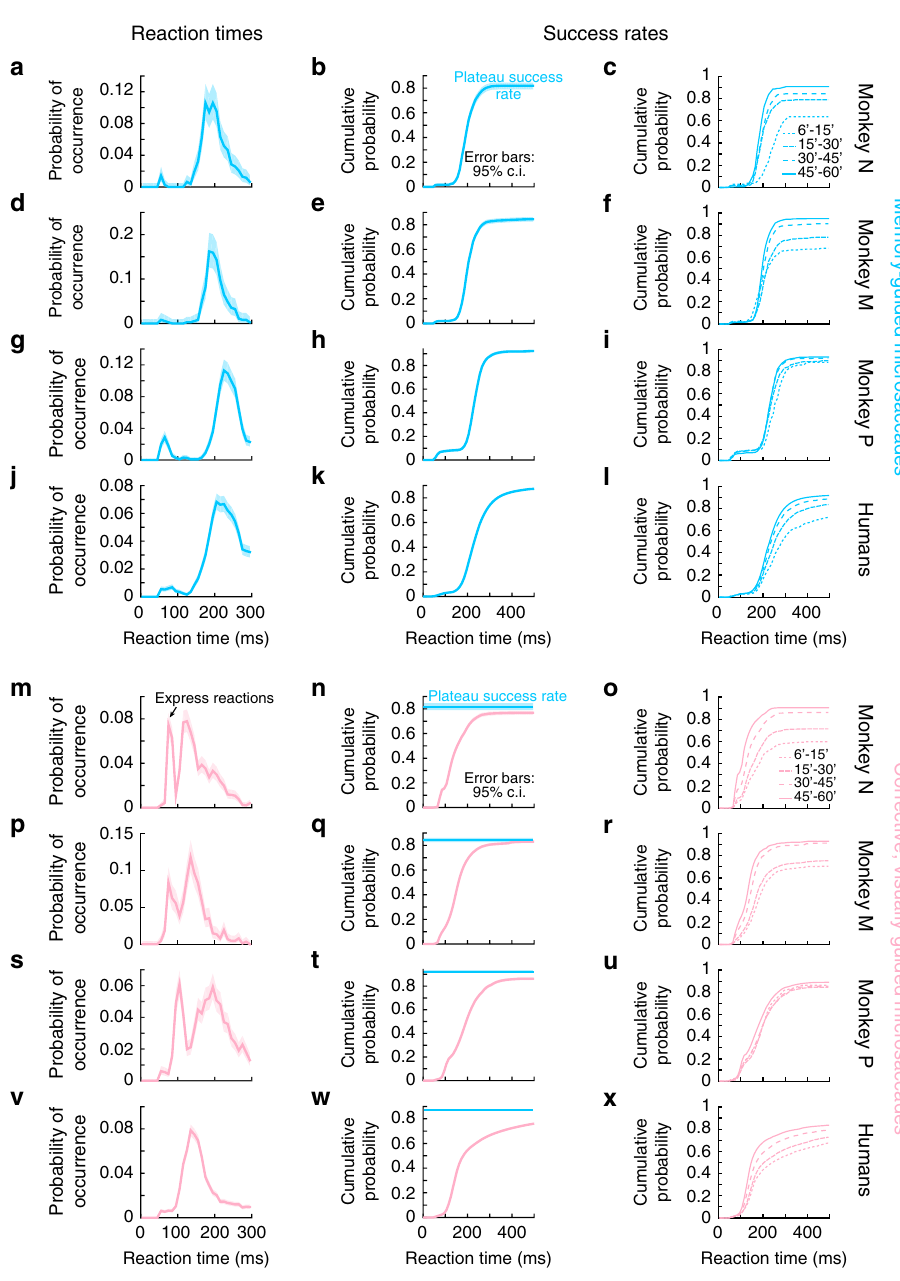
Fig. 2 Memory-guided microsaccades had reaction times and success rates consistent with being genuine responses to task instruction. a Reaction time distribution for memory-guided microsaccades in monkey N. The data shows all trials with target eccentricities <1 o (Methods). The monkey had a reaction time distribution typical of saccadic responses. Error bars denote 95% con fi dence intervals, and the histogram was normalized by the total number of trials. b Cumulative probability of the same data, demonstrating a plateau of >80% success rate; the monkey successfully generated a memory-guided microsaccade (that is, within a reasonable reaction time; Methods) on the great majority of trials. Error bars denote 95% con fi dence intervals. c Same data as in b but separated by target eccentricity (inset legend). Even the smallest target eccentricities were associated with a majority of successful reactions. d – f Similar observations from monkey M. g – i Similar observations from monkey P. j – l Similar observations from our human subjects (Methods). m – x We repeated the same analyses above, but now for corrective, visually guided microsaccades occurring after target reappearance. Reaction times ( m , p , s , v